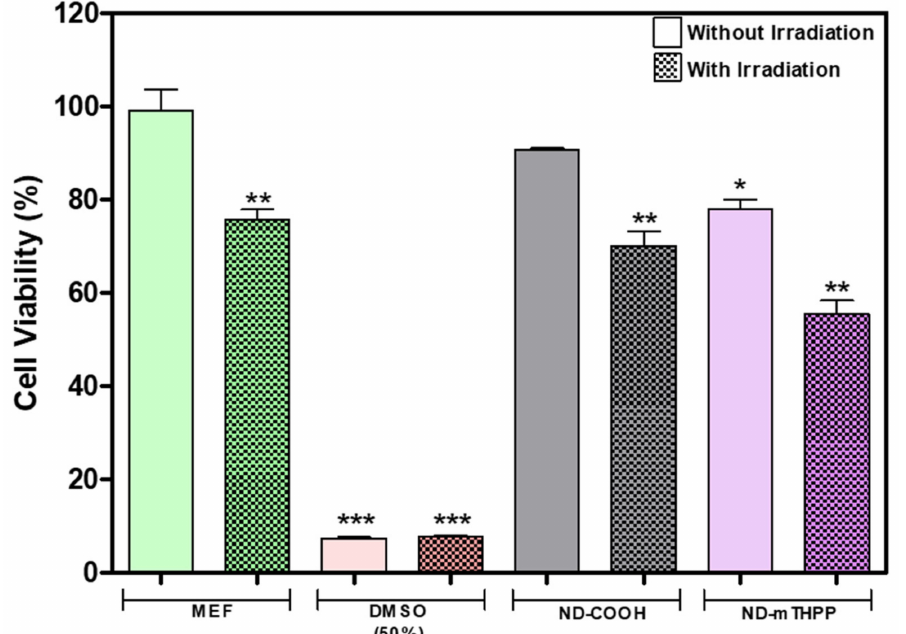
Figure 7. Cytotoxicity ND-COOH (100 µ g/mL) and ND-mTHPP (100 µ g/mL) in MEF culture after 24 h, with and without irradiation. Cell viability of ND-COOH and ND-mTHPP measured using MTT assay. Experiments were repeated in triplicate and significant differences between MEF control (without irradiation) and test samples are marked with * ( p < 0.05), ** ( p < 0.01), and *** ( p <